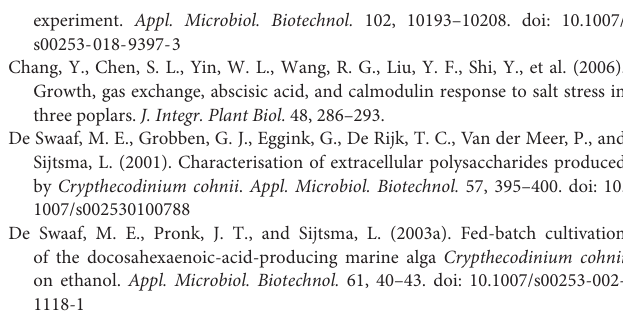
Supplementary Figure 1 | Distribution of the identified proteins in C. cohnii . (A) Distribution of unique peptides. (B) Distribution of protein coverage. (C) Distribution of protein mass. Supplementary Figure 2 | Pathway annotation for all the identified proteins. Supplementary Figure 3 | Classification statistics of the pathways for differentially expressed proteins in FS280 vs.